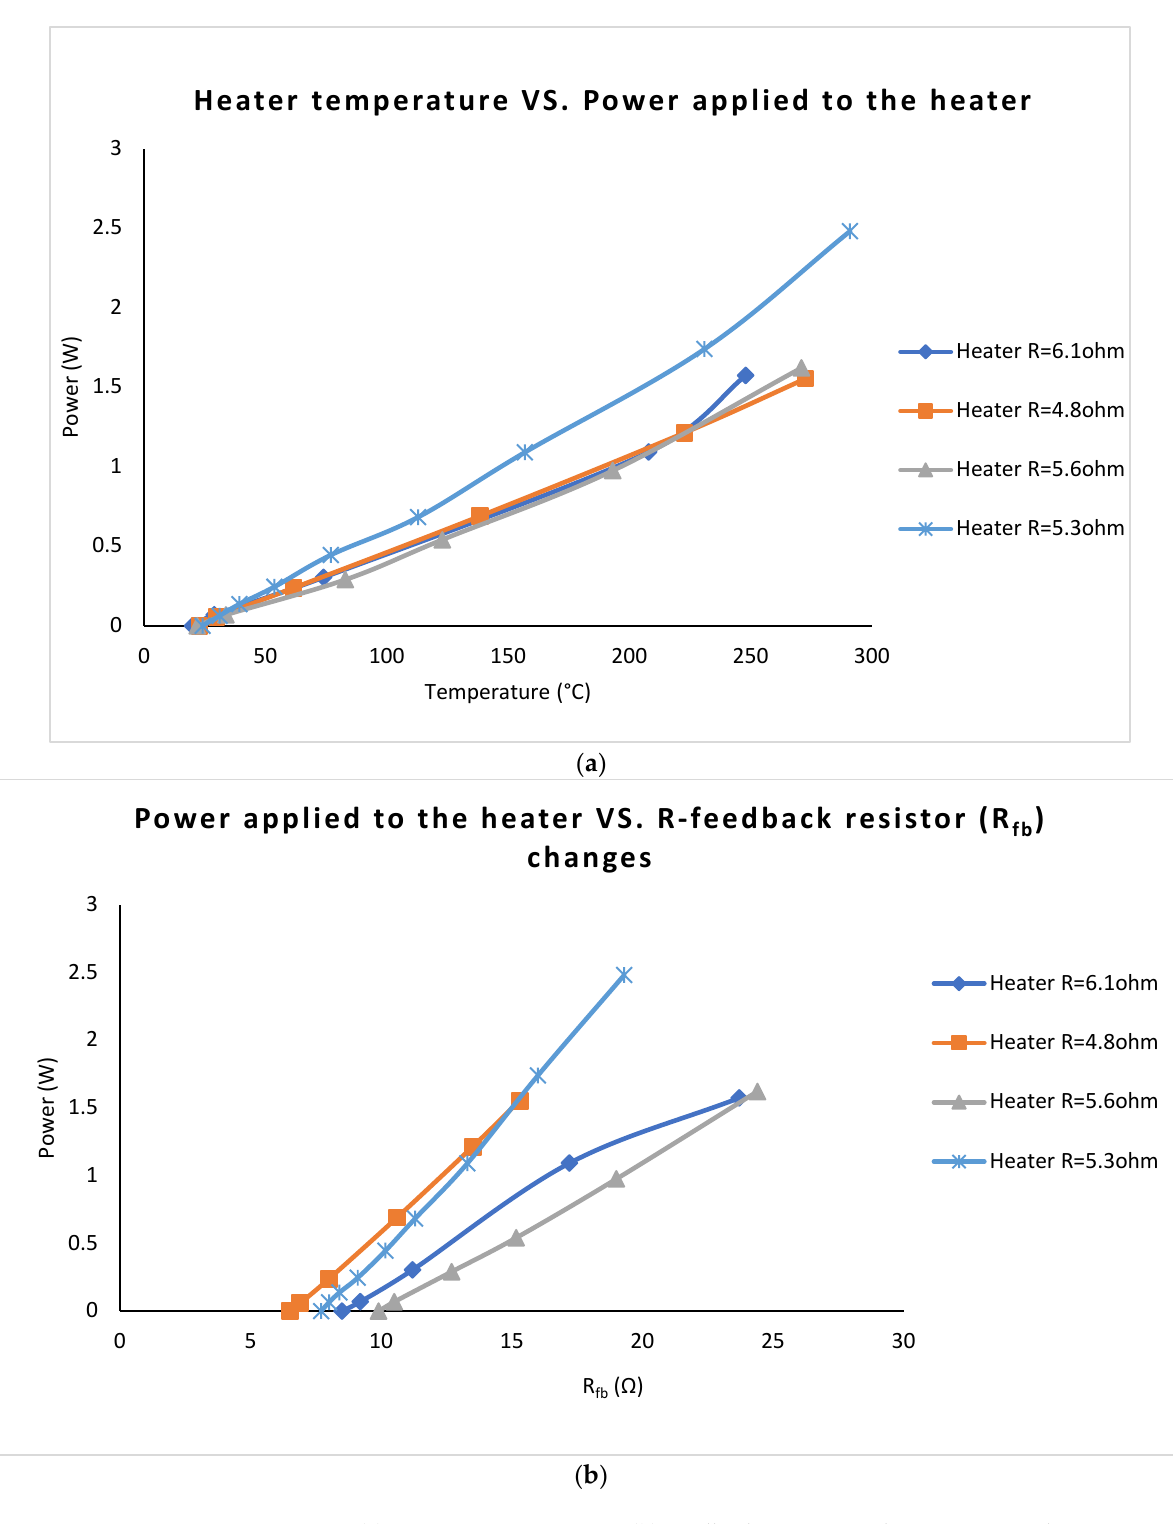
Figure 7. ( a ) Temperature vs. power. ( b ) Feedback resistor’s value variation with power supplied to the heater. Changes in the value of the feedback resistor (R fb ) are consistent with the sensor’s surface temperature changes (Figure 7b). Therefore, the R fb is well suited as the PTC ther- mal sensor for controlling the Cl 2 sensor’s surface temperature. The relationship between power and the feedback resistor is explained by the physical differences in the thickness of the heater and feedback resistor’s tracks caused by the imperfections of the screen- printing process.